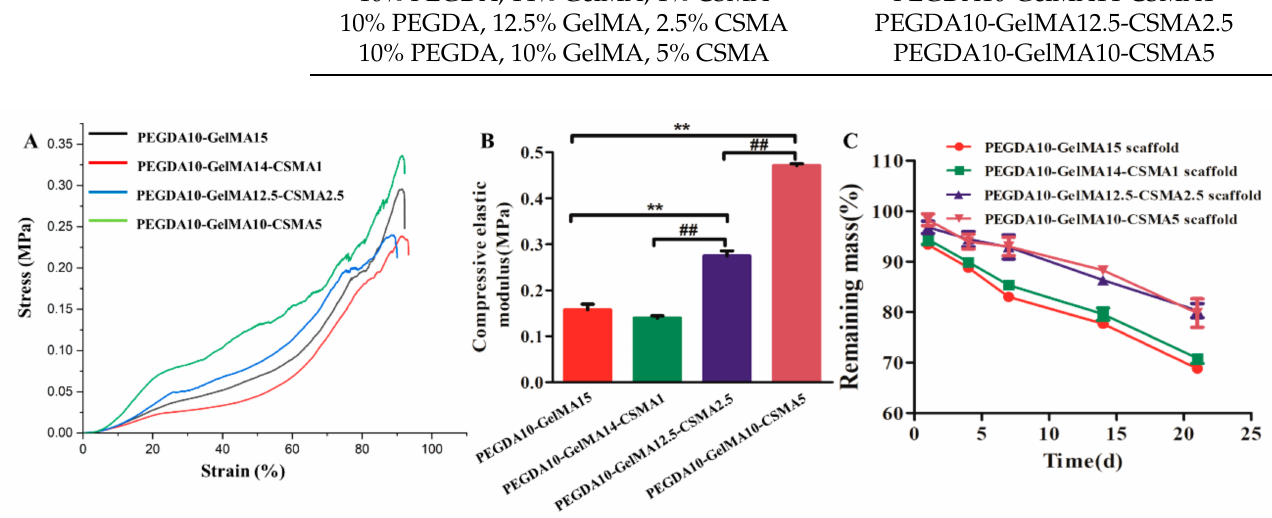
Figure 2. The mechanical properties and biodegradation of 3D-printed hydrogel scaffolds. ( A ) Stress-strain curves. ( B ) Compressive elastic modulus ( n = 3, ** p < 0.01, ## p < 0.01). ( C ) In vitro degradation of scaffolds in protease K at each time point ( n =